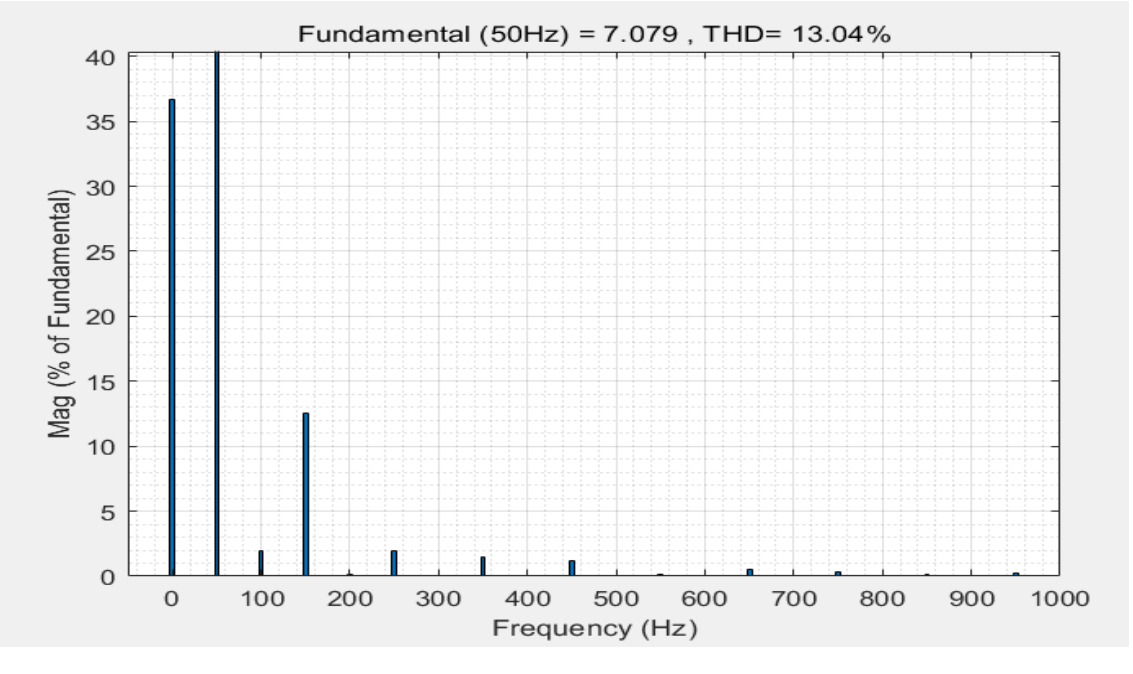
Figure 6. Spectrum analysis of power supply current.